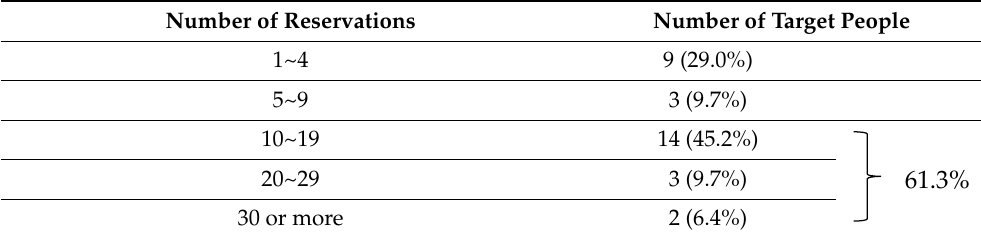
Table 3. Percentage of reservations per person. n = 31, high percentage of multiple users, because you can understand the convenience once you use it.